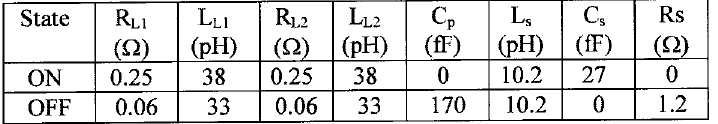
FIGURE 9 The modeled data vs. measurement data for a cantilever